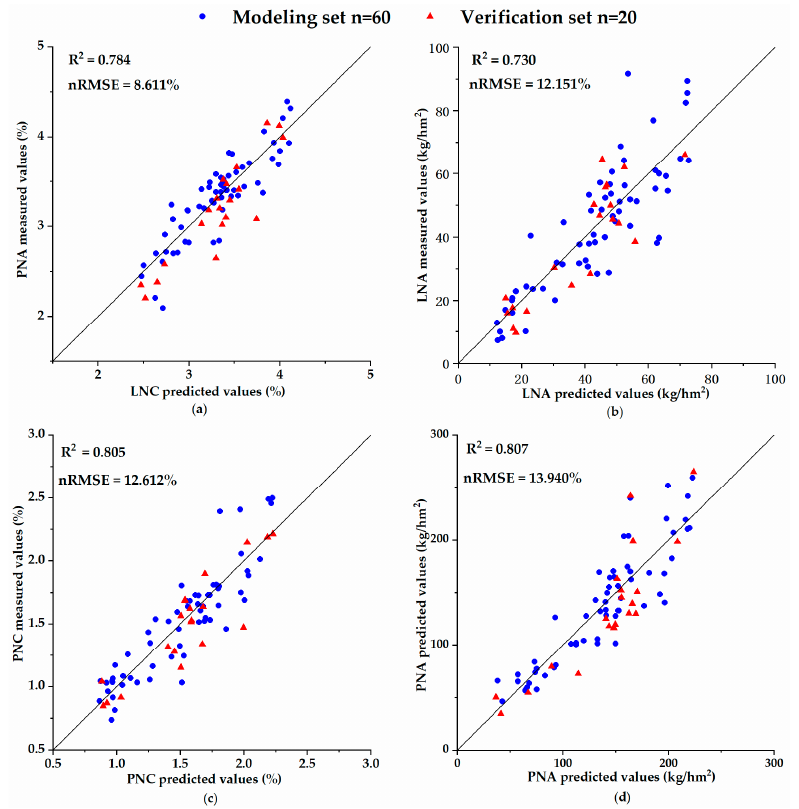
Figure 7. Relationship between predicted and measured values of nitrogen nutrition parameters. ( a )